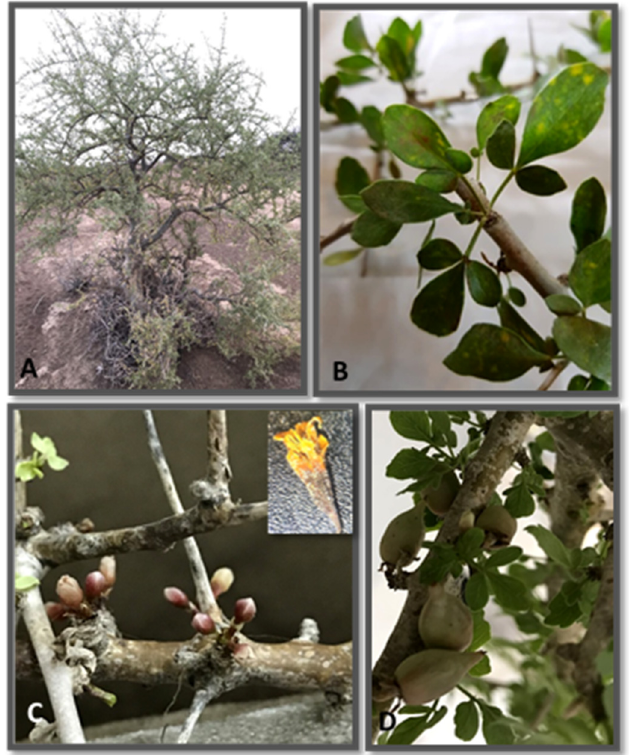
Figure 2. Commiphora myrrha ; ( A ): whole plant in leafy stage; ( B ): leaves; ( C ): floral buds and one flower is magnified at 1.2 × ; ( D ): fruits and leaves.